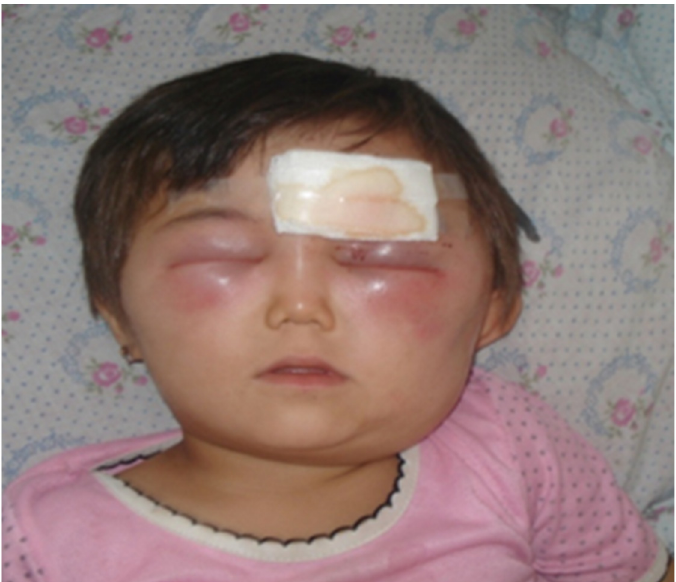
Figure 4. A severe form of cutaneous anthrax on the face. Extensive erythema and oedema can be seen (Image supplied by Professor Ainura Kutmanova and Dr. Saparbai Zholdoshev).